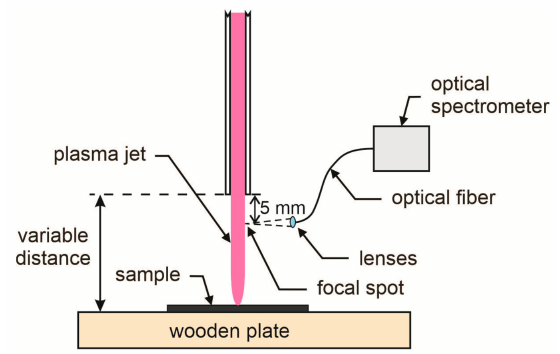
Figure 1. Schematic of the experimental set-up (not to